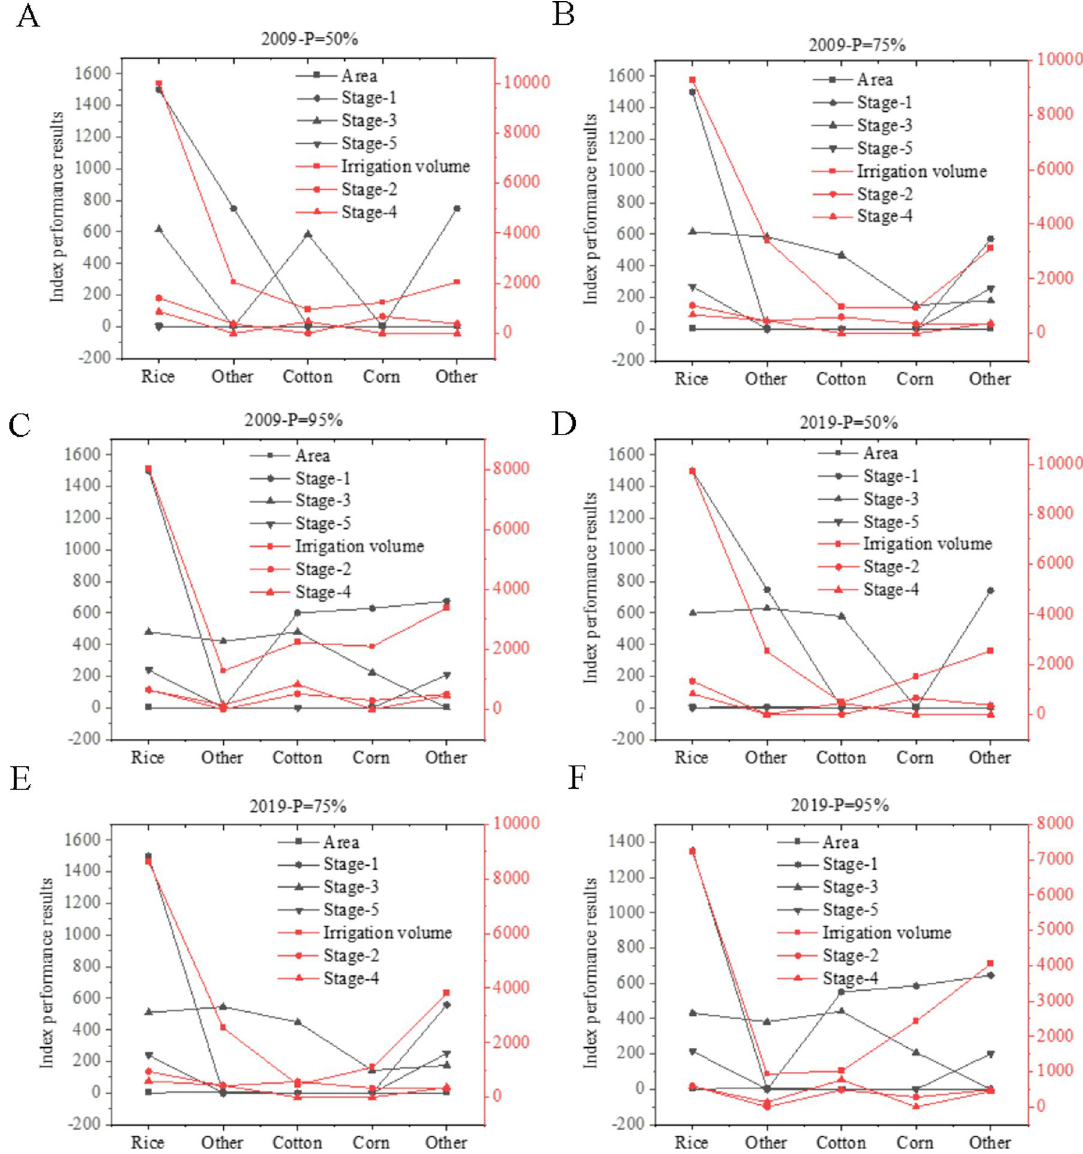
Fig 8. Water resource allocation results of different crops, stages, and